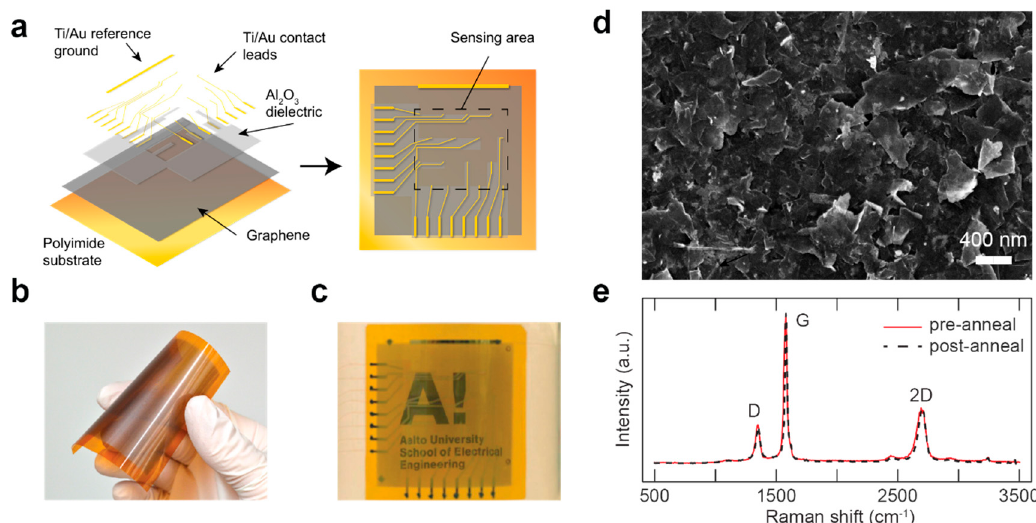
Figure 1. ( a ) Exploded-view drawing and top view of the device architecture. Graphene ink is deposited on a flexible polyimide substrate, followed by the deposition of Al 2 O 3 dielectric layer and Ti/Au readout leads. Graphene film together with the readout leads forms a four-by-four pixel thermal sensing array. ( b , c ) Graphene film on polyimide substrate before ( b ) and after ( c ) the deposition of Al 2 O 3 and Ti/Au layers. In ( c ), the device was attached onto the outer surface of a beaker, demonstrating both the flexibility and transparency of the sensor. ( d ) Scanning electron microscope (SEM) image of the device surface showing the stacked multilayer graphene flakes. ( e ) Raman spectra of the graphene flakes before ( black line ) and after (dashed red line ) annealing. The spectrum remained largely unaffected by the annealing treatment.